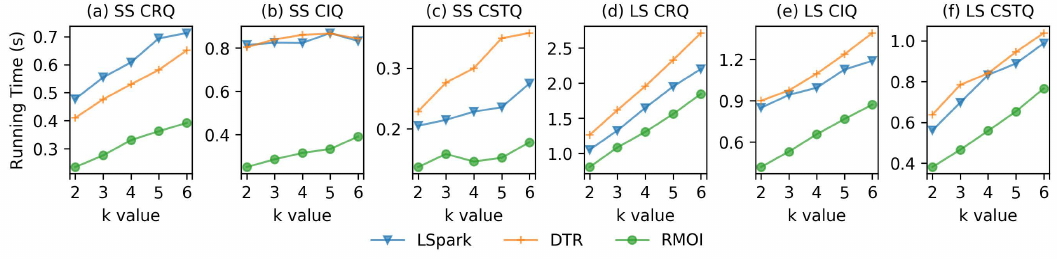
Figure 4. Average execution time for the SF dataset with high resource availability on ( a ) continuous range query with small selectivity, ( b ) continuous interval query with small selectivity, ( c ) continuous spatio-temporal query with small selectivity, ( d ) continuous range query with large selectivity, ( e ) continuous interval query with large selectivity, and ( f ) continuous spatio-temporal query with large selectivity.